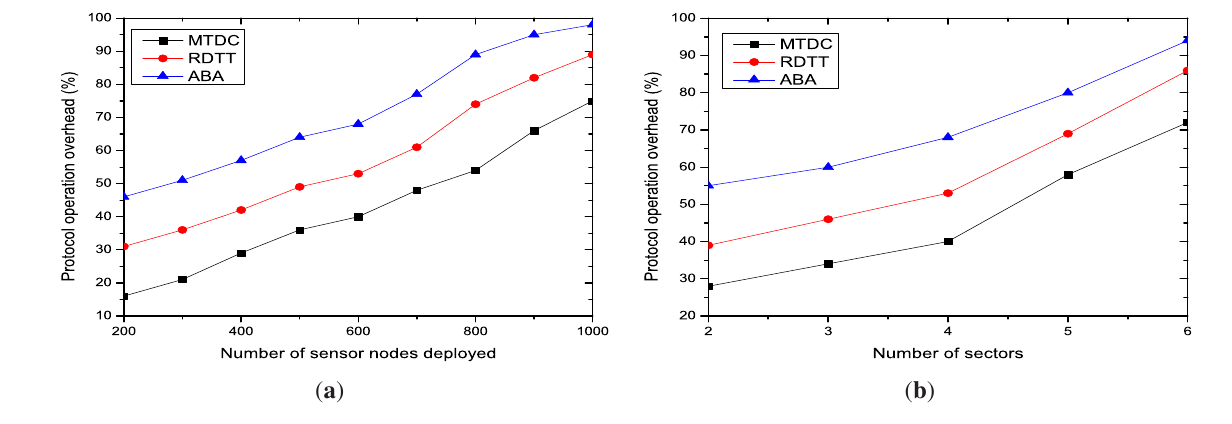
Tracking operation overhead. ( a ) Overhead vs. the number of nodes; ( b ) overhead vs. the number of